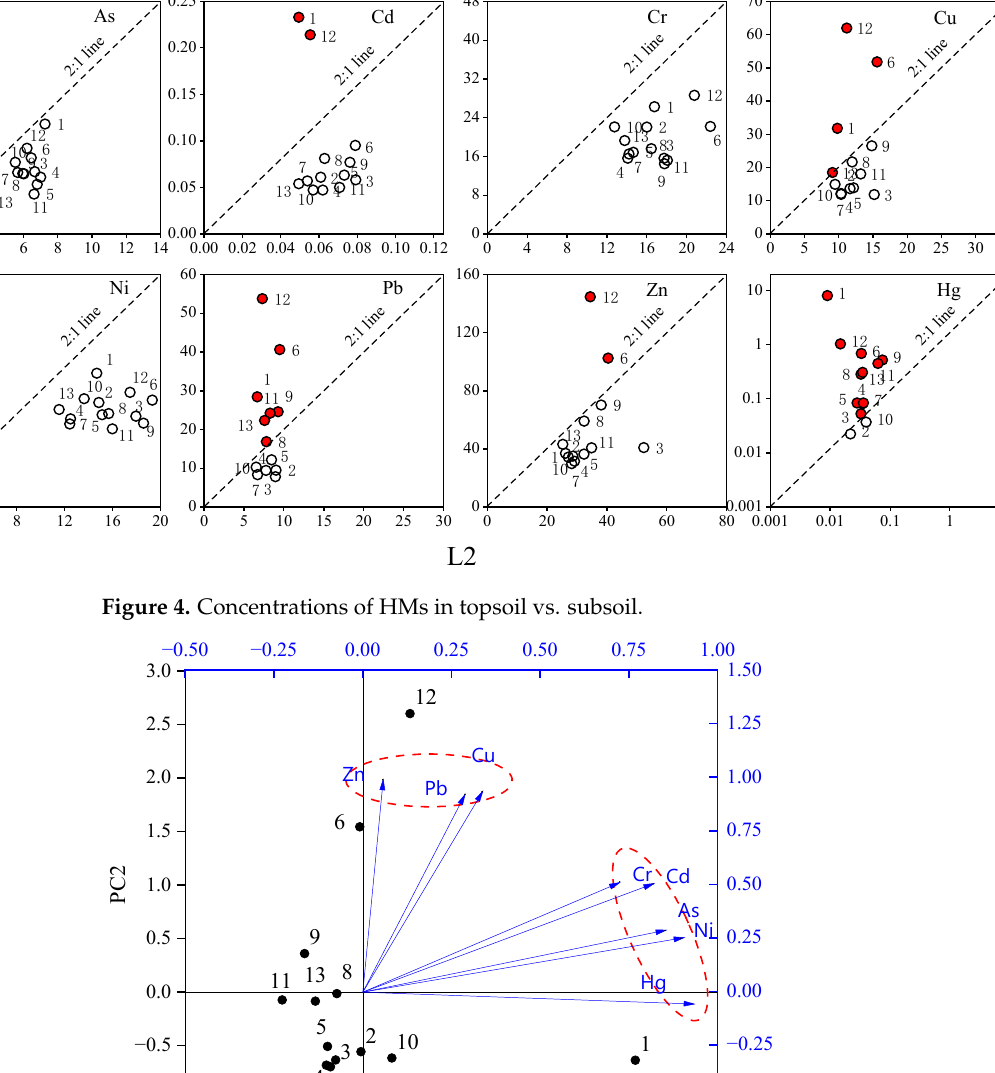
Figure 6. Contribution rates of the different sources of the HMs for topsoil. The first factor accounted for 31.63% of the total variance, featuring high loadings of As (63.11%), Cr (61.67%), and Ni (70.80%). Many studies have reported that Cr, Ni, and As in soil would originate from soil parent materials [7,43,44]. Weathering processes of parent soil materials have been demonstrated to be a significant source for Cr, Ni, and As in both topsoil (0–20 cm) and subsoil (120–180 cm) in the Beijing urban area [45]. Sun et al. [7] found that parent materials and pedogenic processes were major factors in the levels and distribution of Ni, Cr, and As in soils in Tangshan. Ni and Cr are iron group elements; they can substitute for each other and create symbiosis enrichment in minerals [46]. Mul- tiple studies have shown that Ni and Cr are derived from parent materials [47,48]. Ac- cornero et al. [40] reported that the site-specific upper baseline concentration (UBC) of As